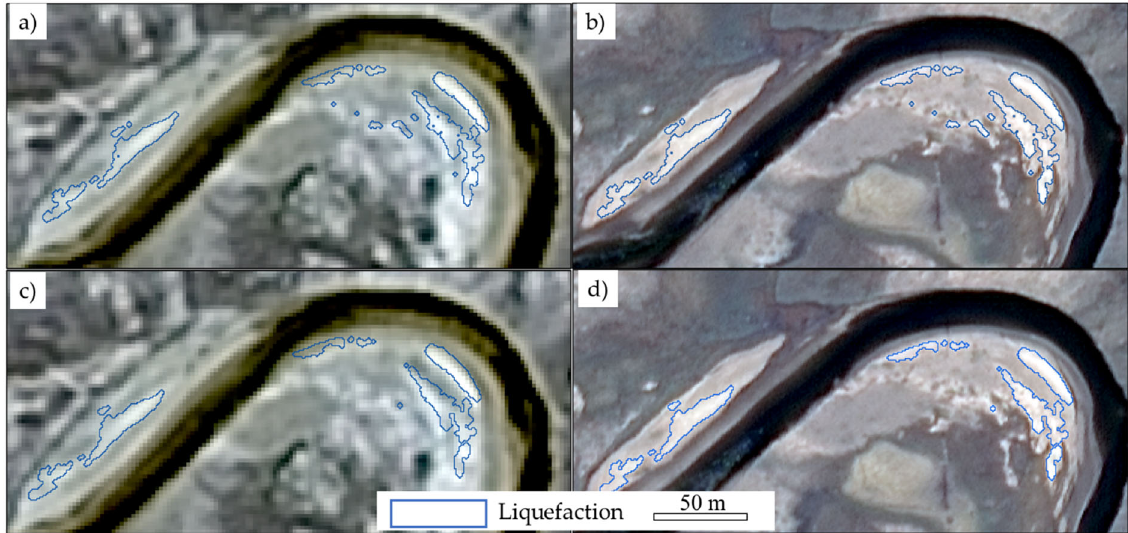
Figure 10. The extracted liquefaction (region Ⅳ ) by the two proposed methods. ( a ) GF-1D image pre-earthquake with liquefaction predicted by RF. ( b ) GF-7 image post-earthquake with liquefaction predicted by RF. ( c ) GF-1D image pre-earthquake with liquefaction predicted by GBDT. ( d ) GF-7 image post-earthquake with liquefaction predicted by GBDT.